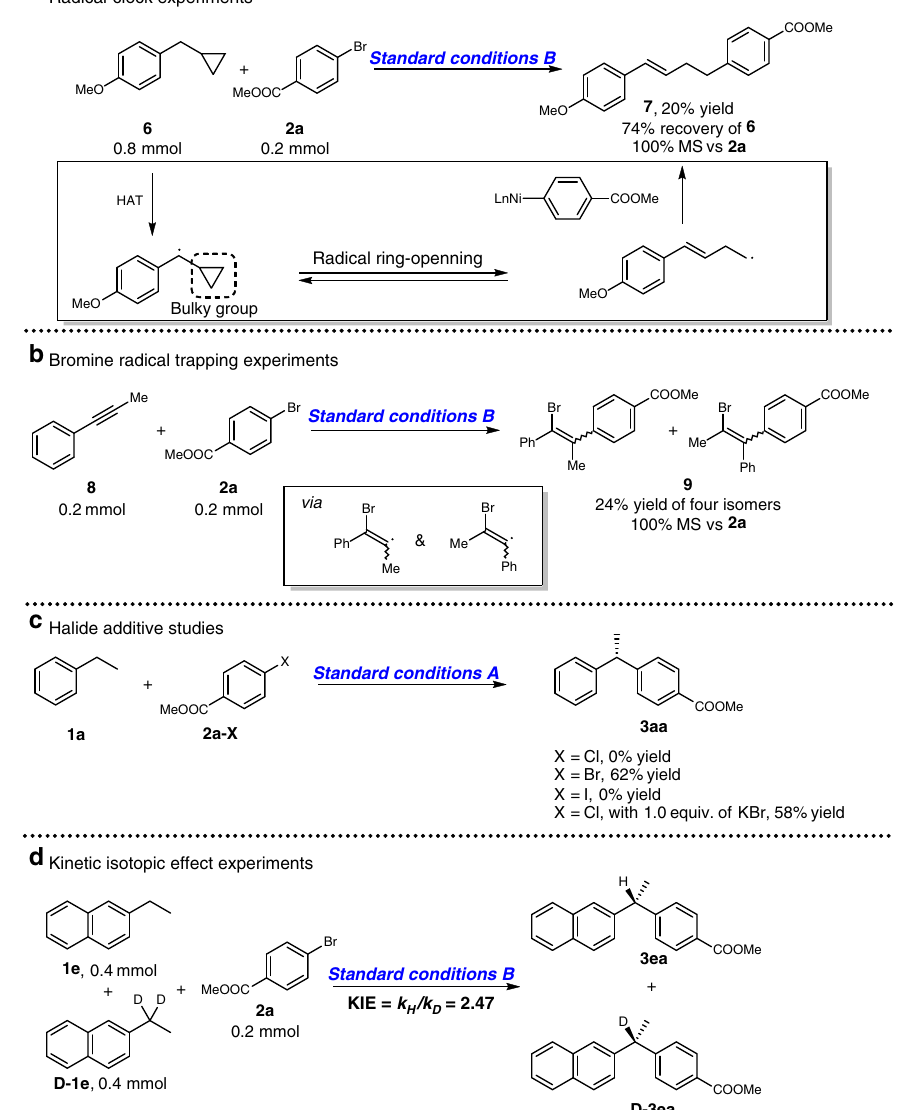
Fig. 3 Mechanistic studies. a Radical-clock experiments consistent with the existence of benzylic radicals. b Compound 8 was added in the absence of ethylbenzene 1a for trapping bromine-free radical under conditions B. c Halide additive studies. d Kinetic isotopic effect was evaluated with 1e